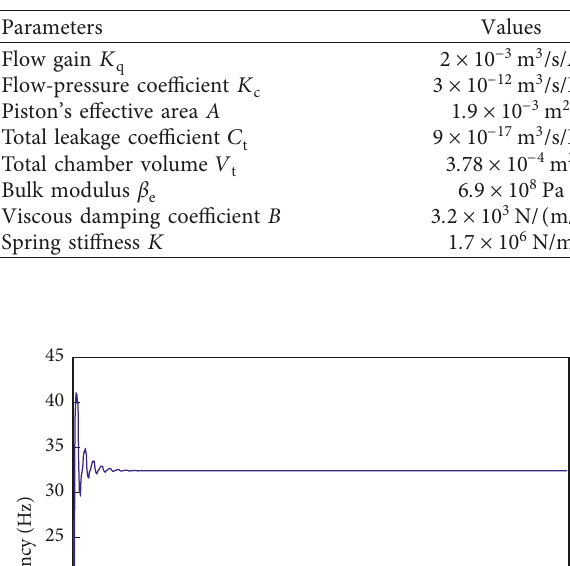
Figure 10: Sine acceleration response. (a) Tracking performance. (b) Tracking error. Table 2: Main parameters of the hydraulic shaking table.